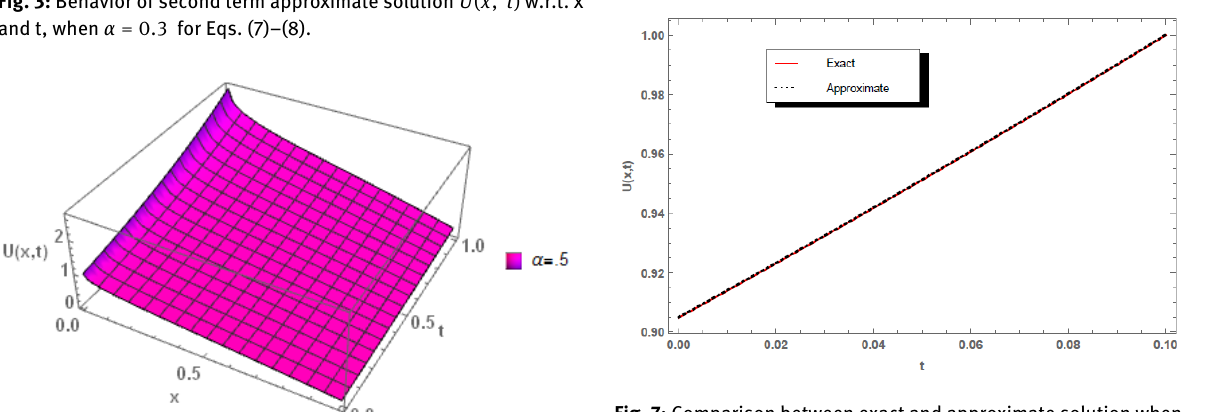
Fig. 7: Comparison between exact and approximate solution when α = 1 for Eqs. (7) – (8). from figs. 1-2 that the approximate solution obtained by FVIM is almost identical with exact solution at α = 1 for different values of x and t . From fig. 7, it is found that ex- act and approximate solutions are in complete agreement at α = 1. It is also to be noted that only eight terms of